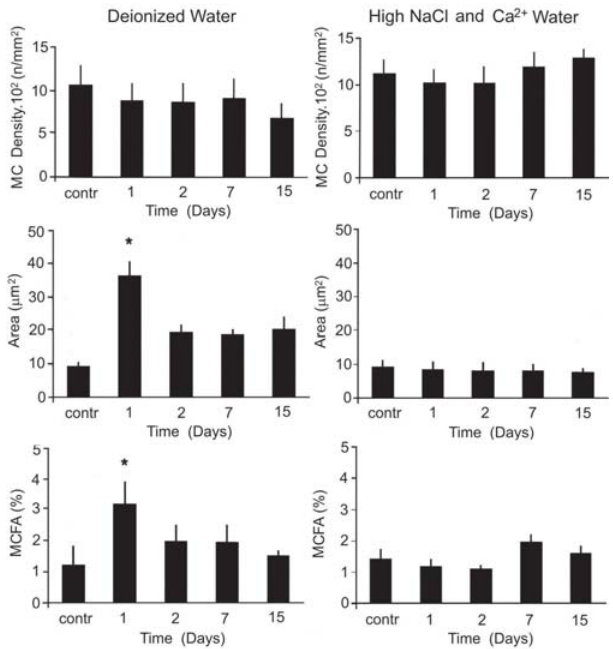
Fig. 3. Mean values (± SEM) of mucous cell density, individual surface area and mucous cell fractional area (MCFA) at filament epithelial surface of Hoplias malabaricus exposed to deionized water and high ion concentration water.